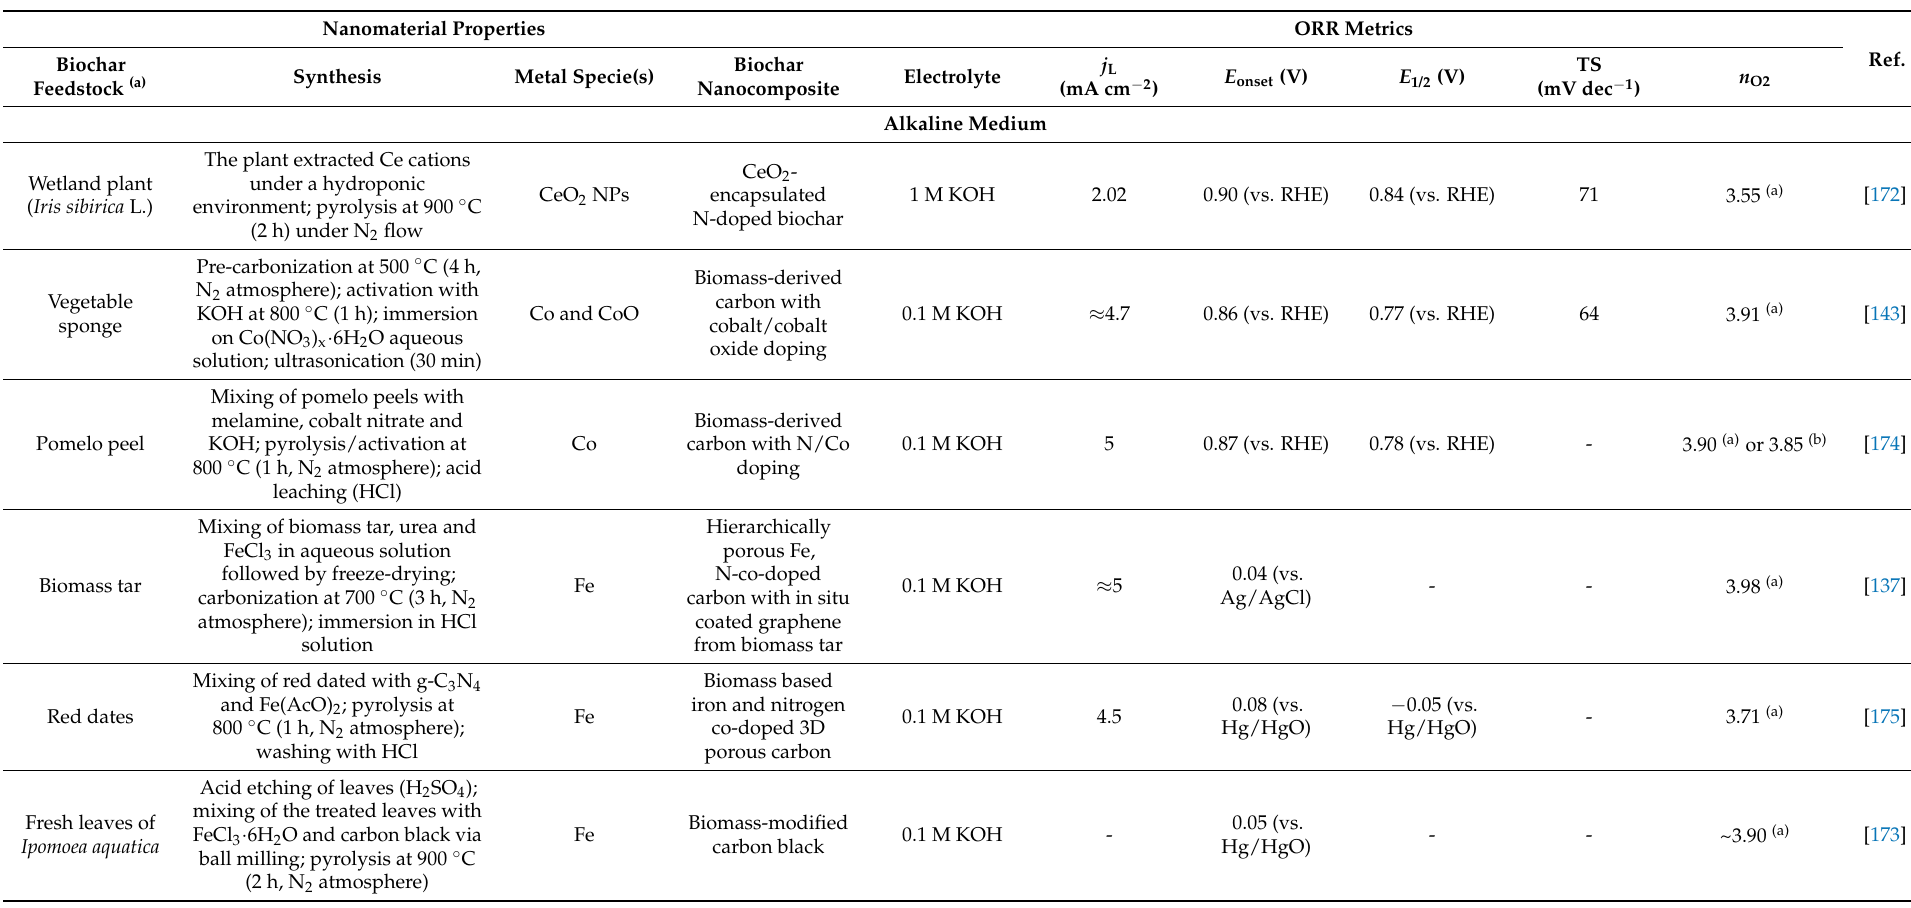
Table 7. Electrocatalytic performance of metal-supported biochar-based materials for ORR in alkaline, neutral, and acidic